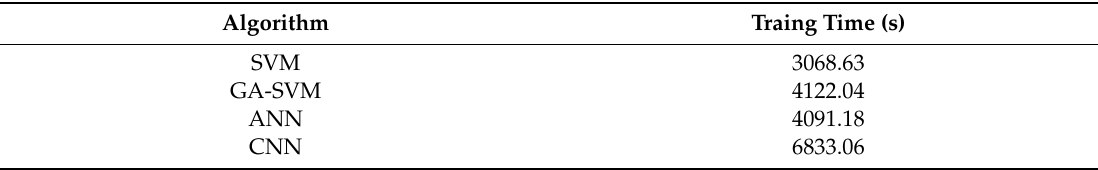
Table 6. Training time with di ff erent